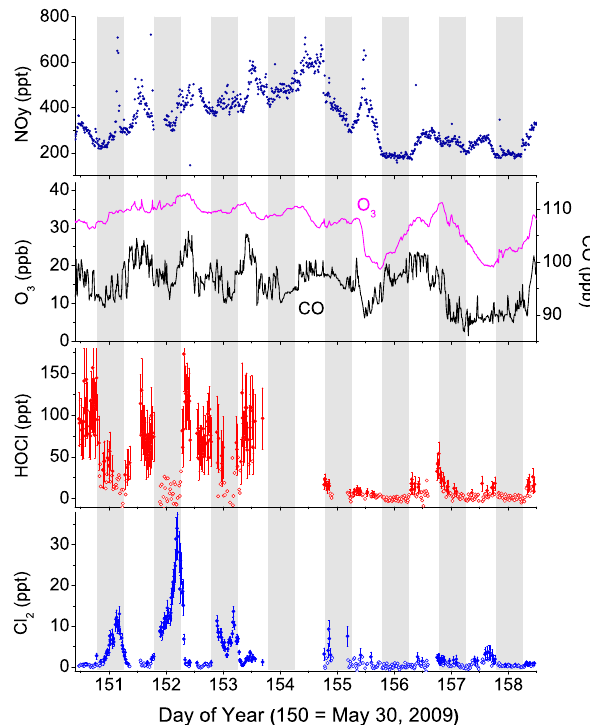
Fig. 2. NO y , O 3 , CO, HOCl, and Cl 2 during the 2009 Cape Verde field campaign. For HOCl and Cl 2 , open circles indicate measure- ments below detection limit. Each point is a 15-min average, and error bars are one standard error of the mean. Shaded vertical bars represent nighttime hours. The day-long gap in HOCl and Cl 2 data about day 154 was due to a power